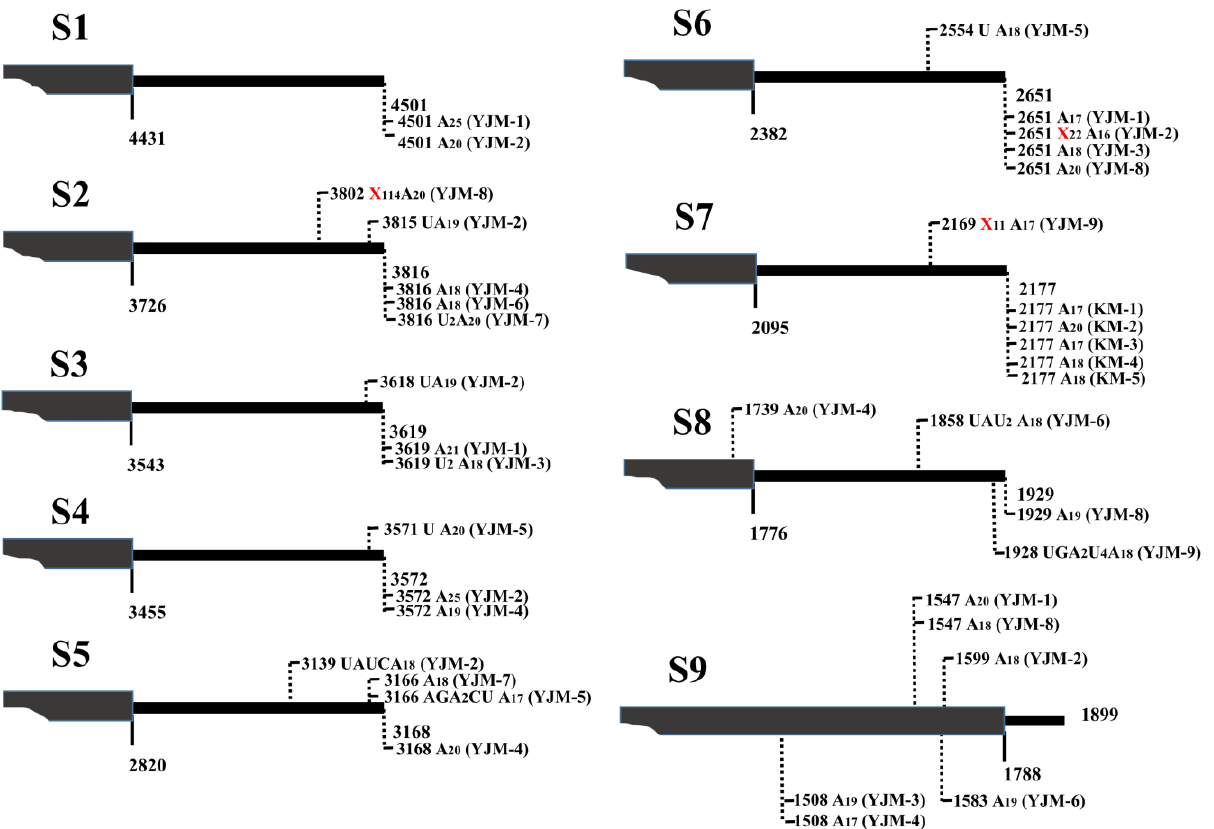
Figure 2. Nature of 3' polyadenylate tails associated with SRBSDV S1-S9 mRNAs in plant. The poly(A) and poly(A)-rich tails of S1-S9 mRNAs are schematically presented respectively, and vertical dashed lines with numbers indicate the exact positions of polyadenylate tails. Nucleotide compositions of the tails are shown, and long non-viral nucleotides are shown with X n . Isolate names in parentheses, KM: Kunming (from rice), YJM: Yingjiang (from maize), Yunnan province. The number after abbreviation is the numbering of isolate